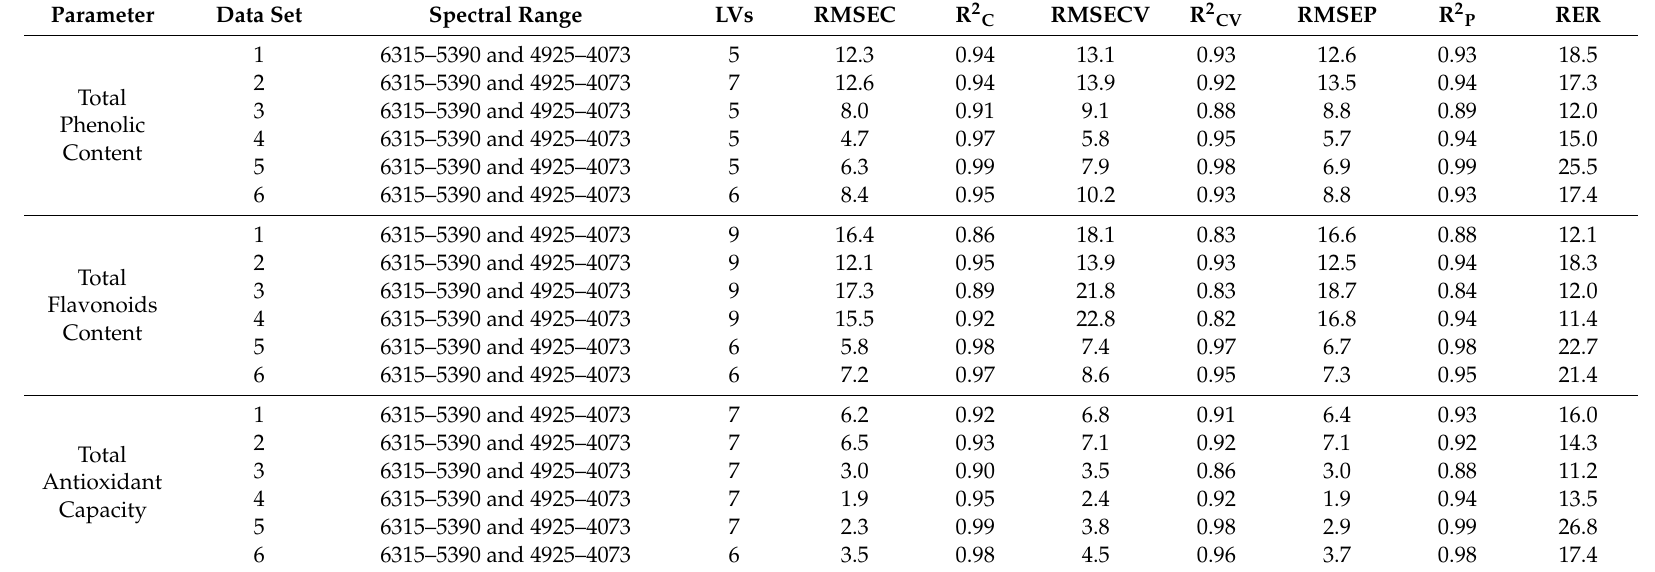
Table 4. Figures of merit obtained from the PLS models developed to predict the total phenolic and flavonoids content and total antioxidant capacity of Vaccinium cultivar leaves by NIR